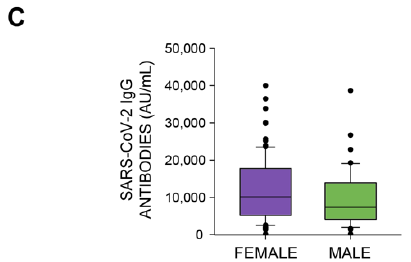
Figure 1. Antibody response following the BNT162b2 vaccine was greater in younger vaccinees. ( A ) Age distribution of study participants. ( B ) SARS-CoV-2 IgG levels across different age groups (Kruskal–Wallis One Way Analysis of Variance on Ranks: p < 0.01). ( C ) SARS-CoV-2 IgG levels in females and males (Mann–Whitney U test: p > 0.05). A positive response is defined as ≥ 50 AU/mL. Participants reported more systemic adverse reactions following the second dose, as opposed to local or no adverse reactions following the first dose (Chi-square, p < 0.001, Figure 2A). These results did not change when accounting for sex (Chi-square, p < 0.001 and p < 0.01 for females and males, respectively, Figure 2B,C).